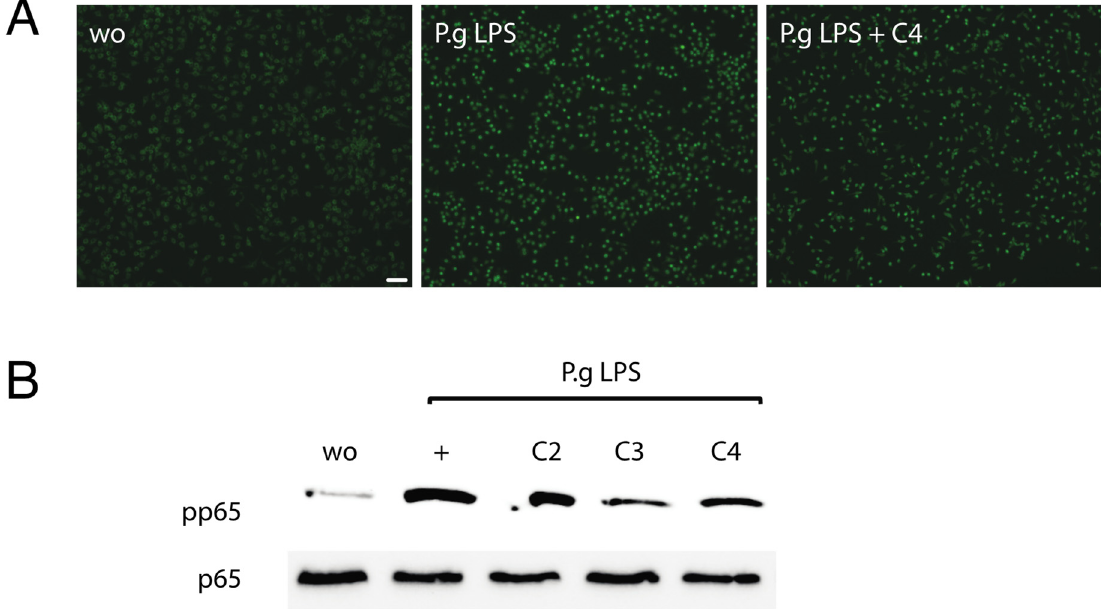
Figure 2. Butyrate reduced NF- κ B signaling in RAW 264.7 cells . RAW 264.7 cells were exposed to 1